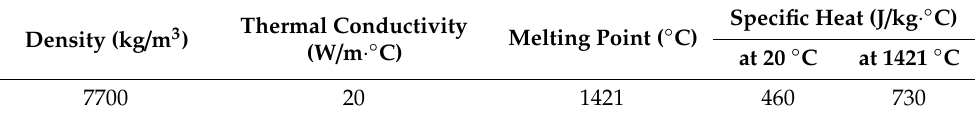
Table 5. Thermal properties of AISI D2 tool steel.